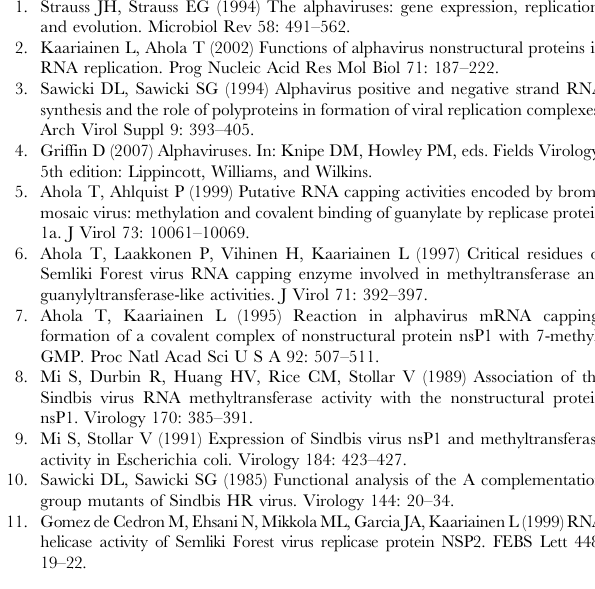
Figure S1 Transposon mutagenesis and alphavirus reverse genetics. A graphical representation of the protocol described in Figure S2 Processing of vRNAs for massively parallel sequenc- ing. A graphical representation of the protocol described in the text. Viral genomic RNAs (vRNAs) are isolated from the supernatant of infected cell cultures. RACE and RT-PCR are used to generate amplicons that span the entire viral genome. The amplicons are mixed in an equimolar ratio, and digested with AscI (added by the primer during PCR) to generate 5 9 phosphorylated ends. This mix is then ligated into a random jumble of high molecular weight DNA (hmwDNA) to generate a starting material for sequencing library preparation. The hmwDNA is nebulized into fragments 400–800 bp in size, and the ends are polished to generate blunt, 5 9 phosphorylated ends. Sequencing adapter ‘‘B’’ (shown in green) from the Roche library preparation kit is ligated onto both ends of the polished DNAs. This mixture is then digested with NotI to expose the ends of the transposon insertions, and a biotinylated modified adapter ‘‘A’’ (shown in blue) is ligated onto the exposed NotI ends. The mix is bound to streptavidin coated magnetic beads and washed to remove any fragments lacking the biotin tag. Templates for GS-FLX sequencing are eluted from the magnetic beads as single stranded DNA. Figure S3 Comparison of electropherogram data to results ob- tained by sequencing. Electropherogram data (top), and sequencing